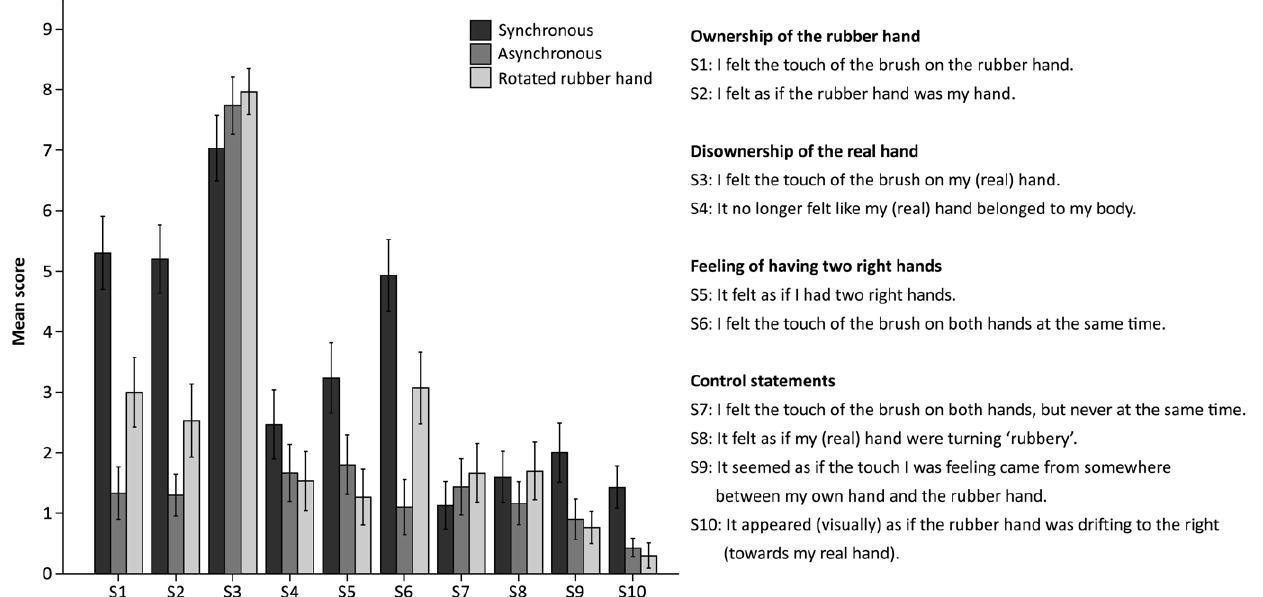
Figure 4. Introspective evidence for the supernumerary hand illusion. Questionnaire data from experiment 1 comparing synchronous brushing (the illusion condition) with asynchronous brushing and using a rotated rubber hand (the control conditions). The questionnaire consisted of ten statements, S1–S10, and the participants indicated their responses on a ten-point visual analogue scale ranging from 0 (‘‘I do not agree at all’’) to 9 (‘‘I agree completely’’). We observed significantly stronger rubber hand ownership (S1–S2) (p , 0.001 and p , 0.001, respectively), no significant difference in real hand disownership (S3–S4) (p=0.137 and p=0.063, respectively) and a significantly stronger feeling of owning two right hands (S5– S6) (p , 0.001 and p=0.002, respectively) during the synchronous condition compared to the asynchronous and rotated rubber hand control conditions, respectively. The error bars represent the standard error.